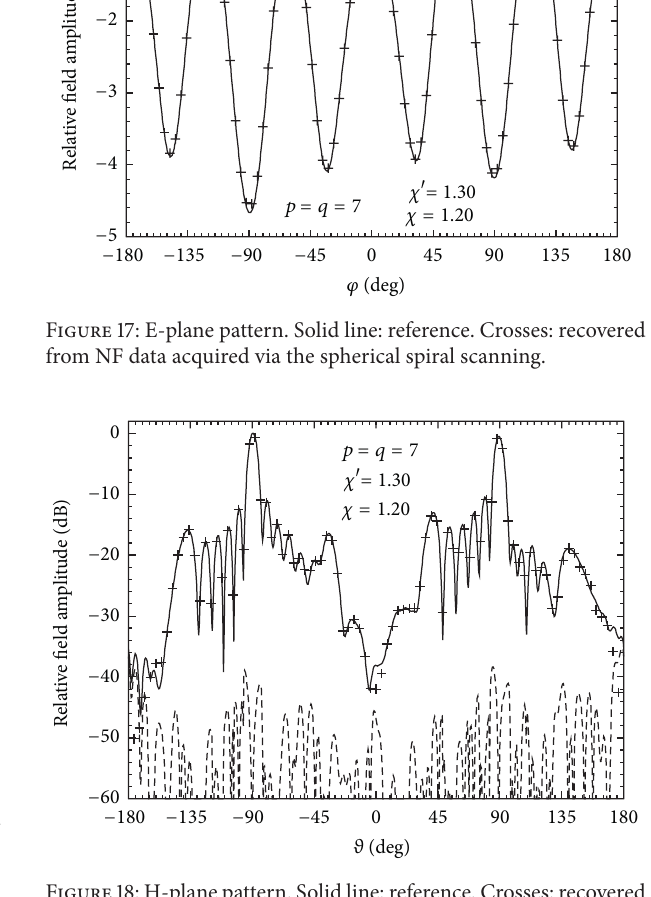
Figure 18: H-plane pattern. Solid line: reference. Crosses: recovered from NF data acquired via the spherical spiral scan. Dashed line: reconstruction